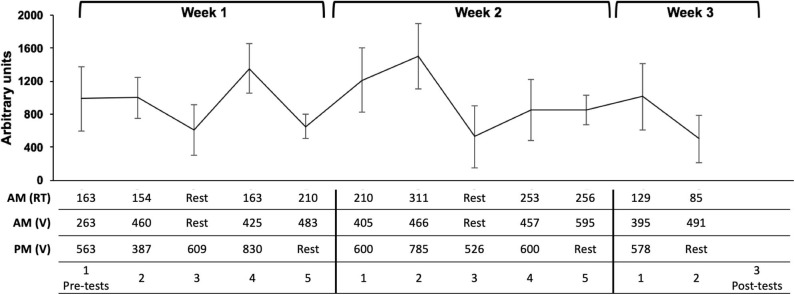
Figure represents mean ± SD daily sRPE (arbitrary units). The table represents the average of the session sRPE (arbitrary units) for each training session. RT, resistance-training session; V, Volleyball training session.